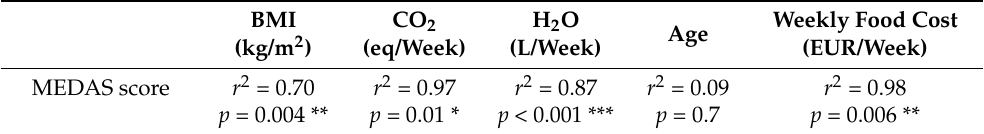
Table 7. Multiple linear regression based on the stepwise method. Statistical significance